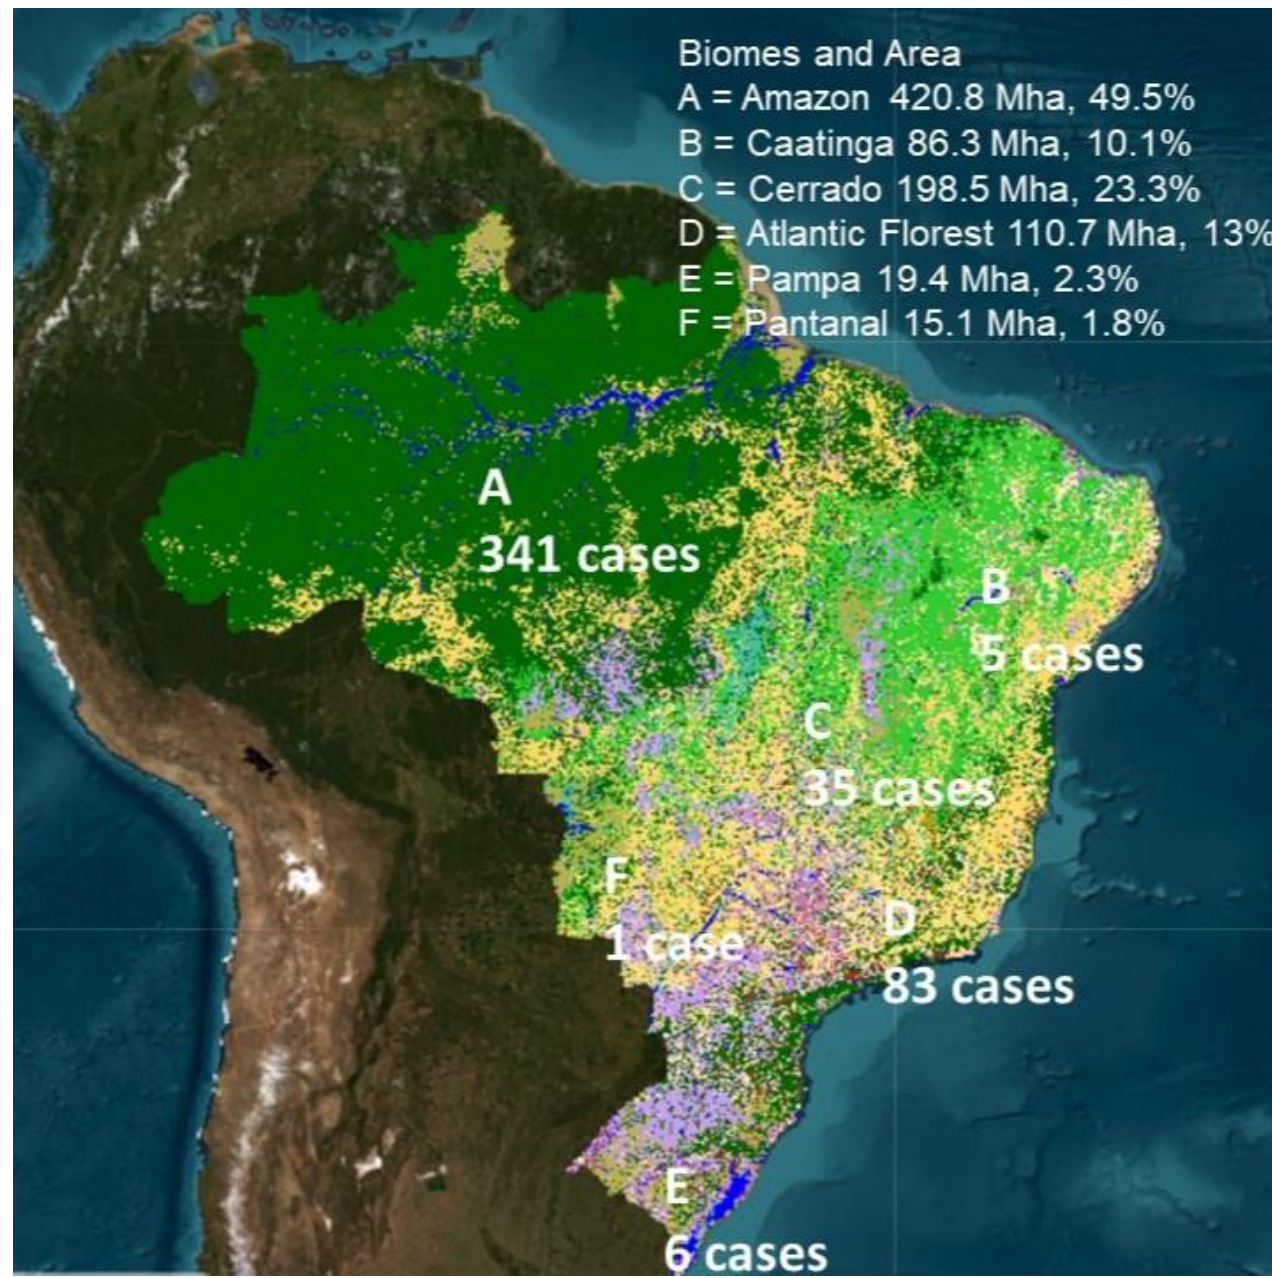
Figure 3. Map of Brazilian biomes containing the total number of cases retrieved in our systematic review of the literature on in situ aerosol–PBAP research built using the MapBiomes project (available at: mapbiomas.org, as per [17]).